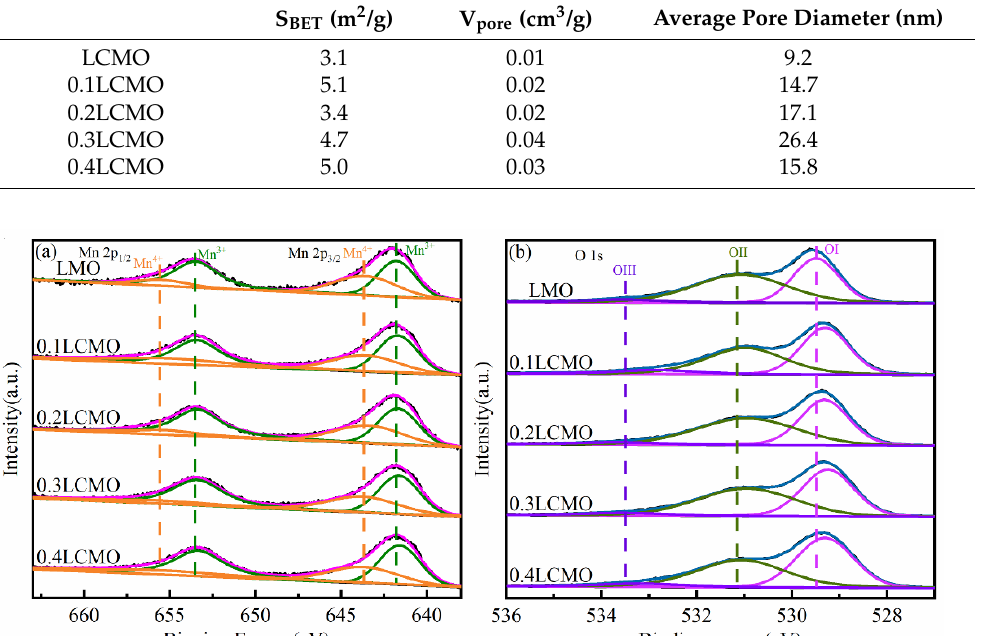
529.5eV, surface electrophilic oxygen species (O Ⅱ ) near 530.9 ~ 531.1eV and the hydrox-